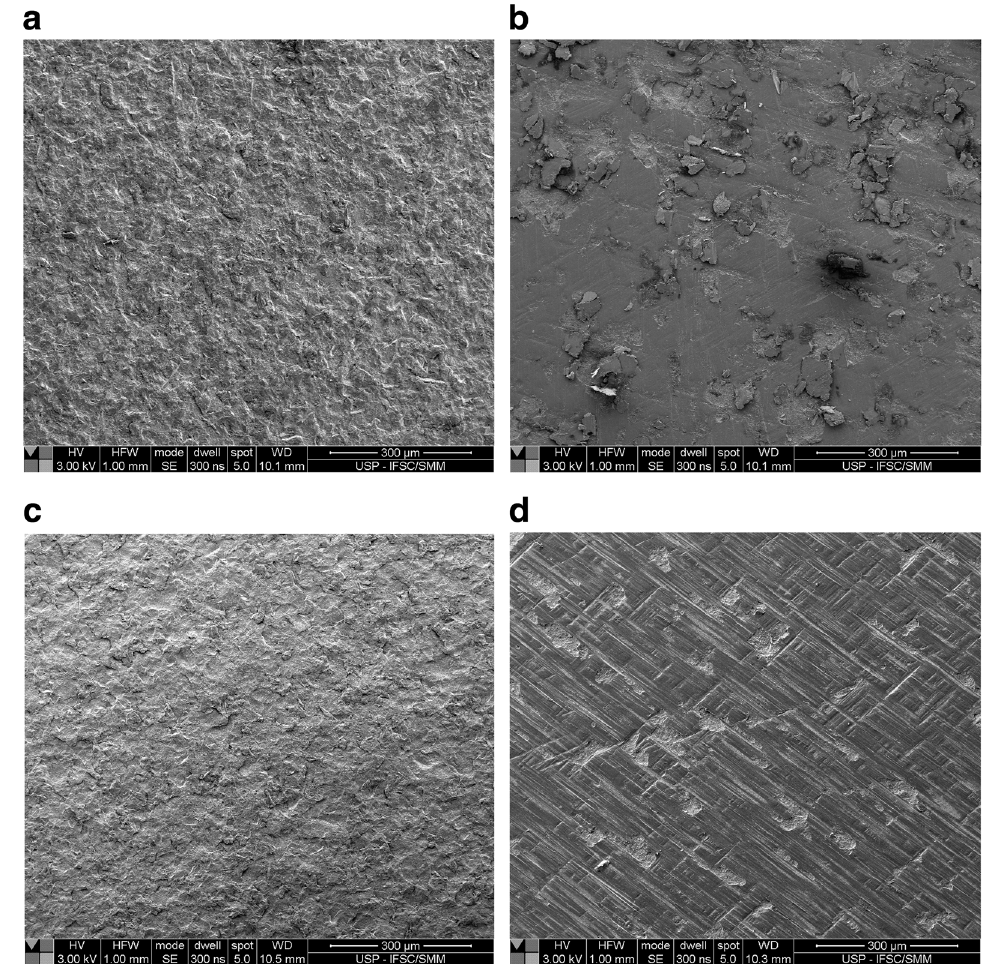
Fig. 5 Surface microstructure corresponding to the experimental groups: a group C, b group CG, c group E, d group EG (300- μ m scale bars)